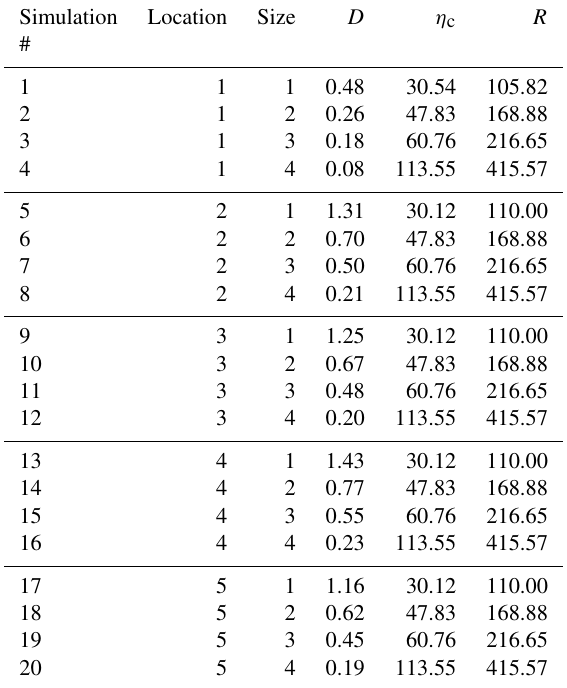
Table 3. Table of all scenarios simulated around Lake Taup¯o. Simulation